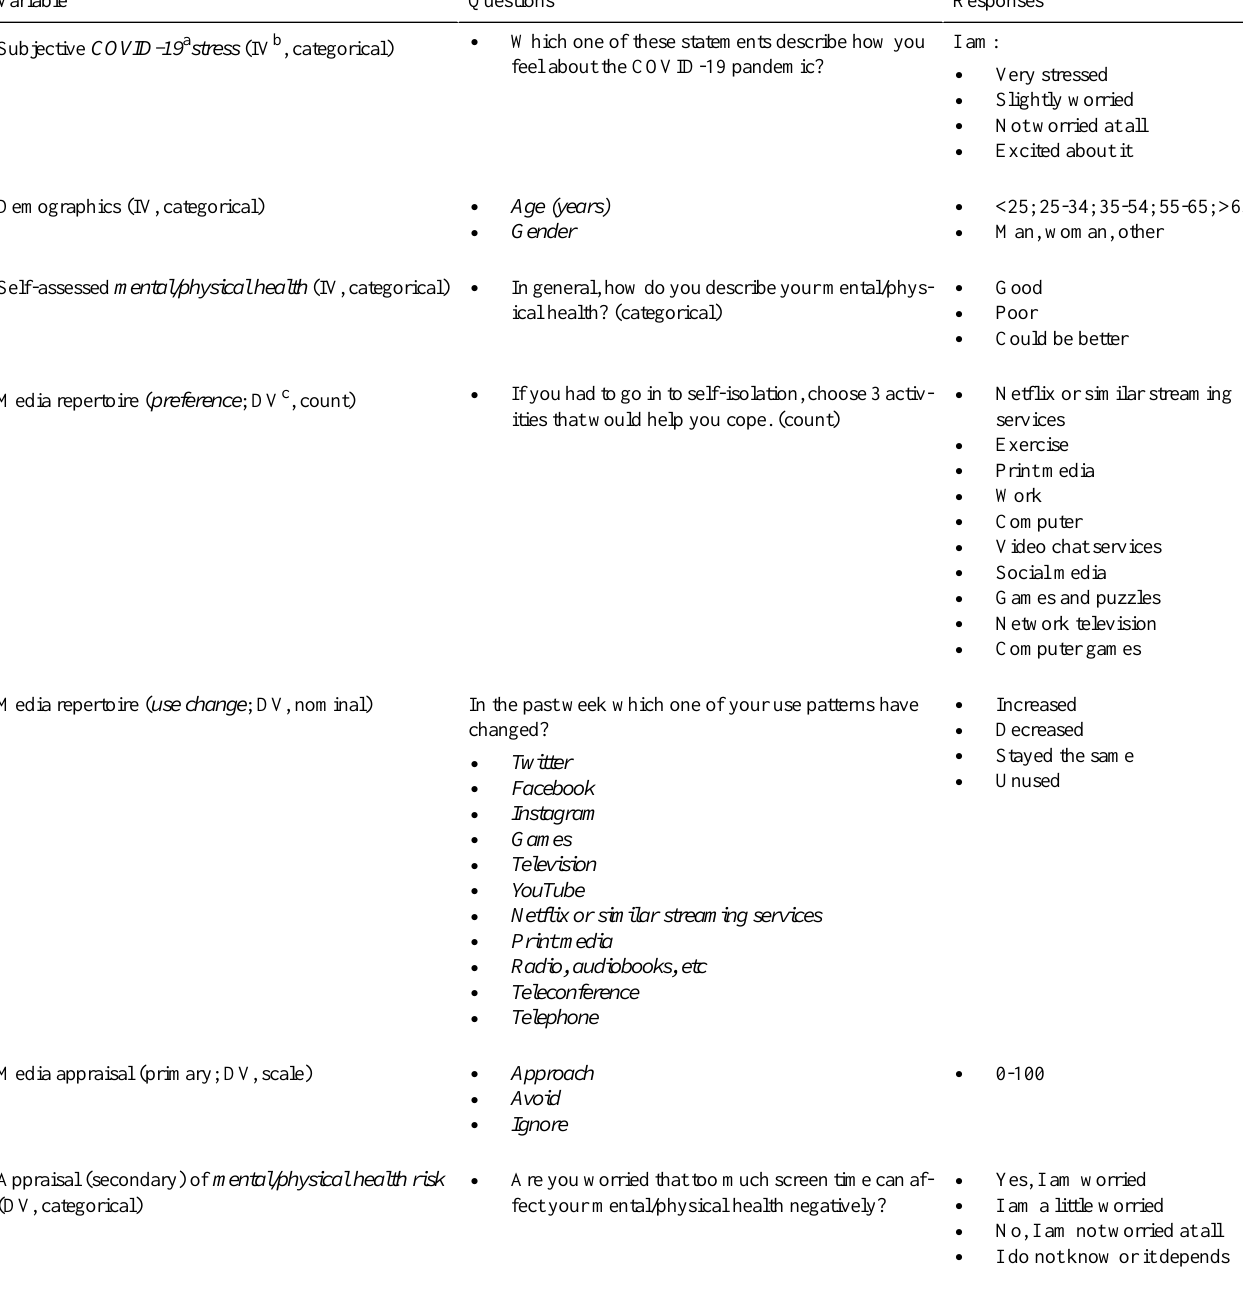
Table 1. List of variables.